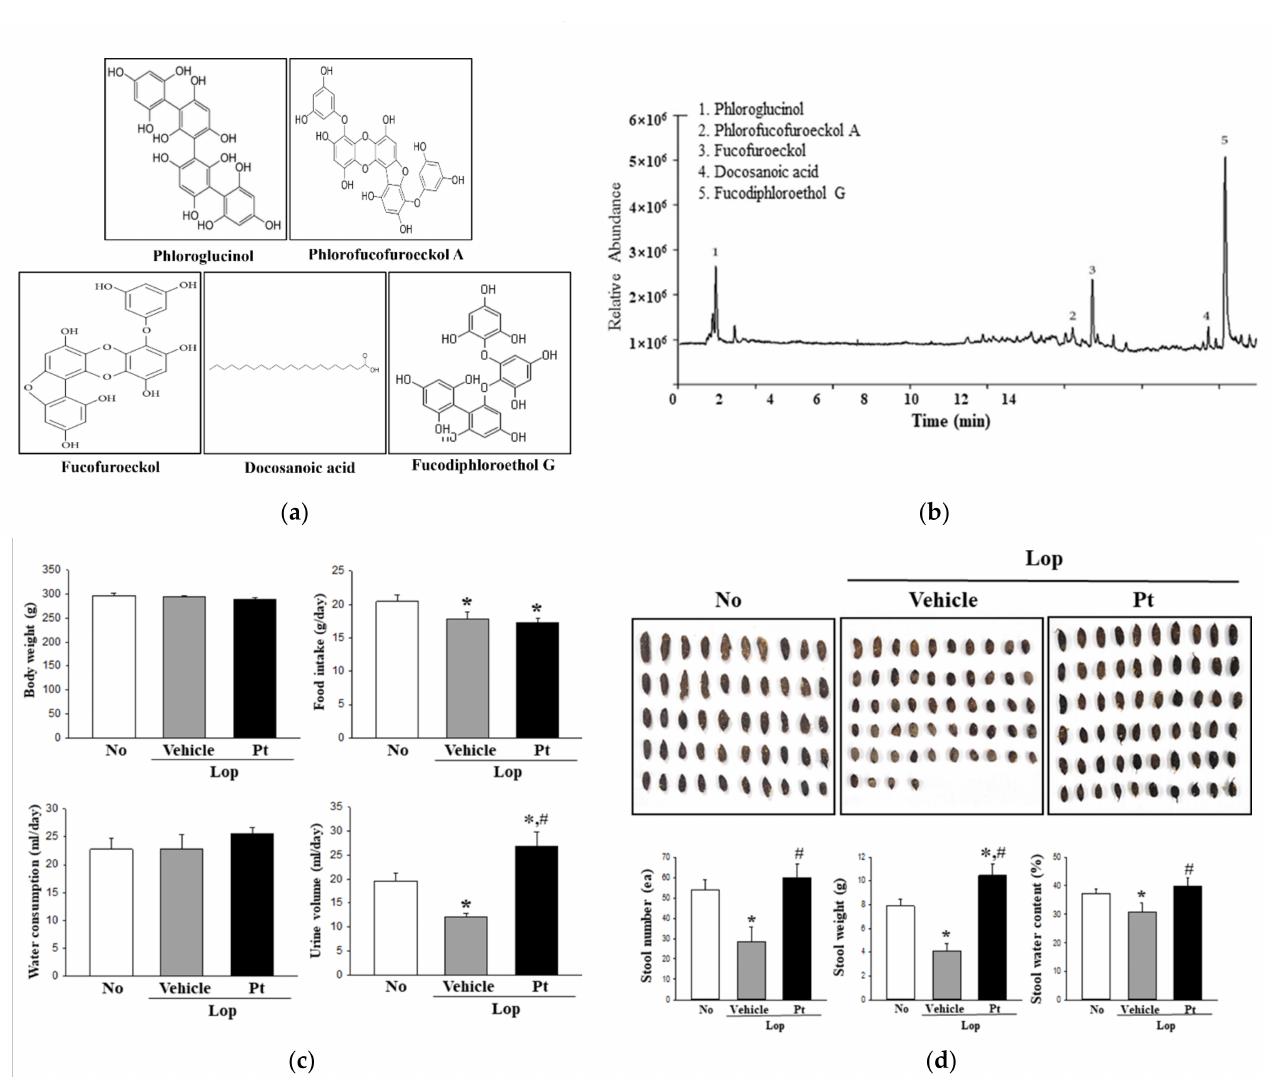
Figure 1. Pt chemical properties, feeding behavior, and stool parameter analyses. ( a ) Chemical structure of five identified compounds. ( b ) LC–MS analysis of Pt. Five active compounds, namely, phloroglucinol (9.35%), phlorofucofuroeckol A (3.11%), fucofuroeckol (7.55%), docasanoic acid (2.06%), and fucodiphloroethol G (31.88%), were detected as different peaks in the chromatogram. ( c ) Feeding behavior analysis. Body weight and urine volume were measured as described in Materials and Methods. The amount of water (feed) supplied and water (feed) remaining were used to measure food intake and water consumption. ( d ) Stool parameter analysis. After collection of stools from the metabolic cage, the total number and weight of stools were measured in duplicate, and their images were taken immediately using a digital camera. Stool water content was calculated as described in Materials and methods. A total of 8–10 SD rats were used for stool collection in each group, and each feeding behavior parameter and excretion parameter were assayed in duplicate. The data are reported as the mean ± SD. *, p < 0.05 compared to the non-treated (No) group. #, p < 0.05 compared to the Lop+Vehicle-treated group. Abbreviations: Lop, loperamide; Pt,